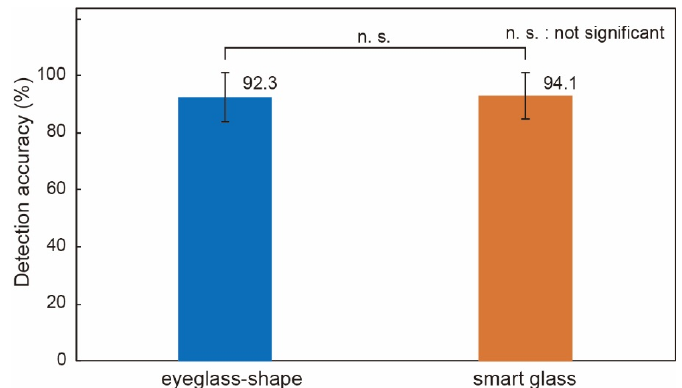
Figure 5. Blink detection accuracy. The results obtained by the smart glass system were compared to the eyeglass system in our prior work and showed no significant difference. Four subjects participated in the experiments for each device.